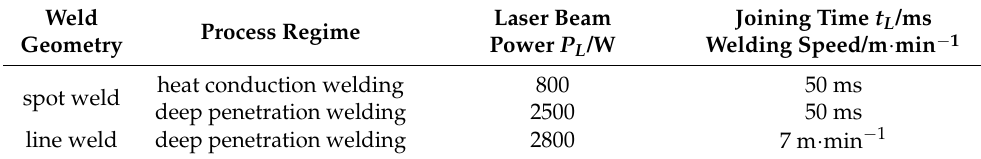
Table 3. Welding parameters for heat conduction and deep penetration